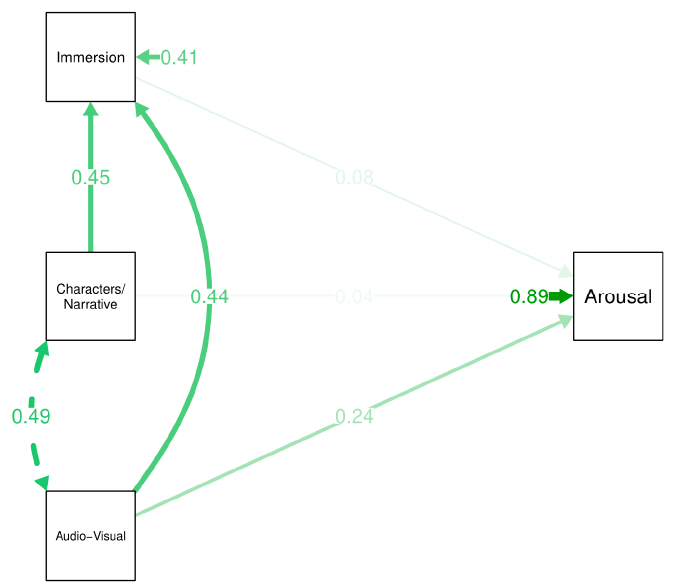
Figure 3. Path diagram for partial mediation model of arousal. Note: aud = audio-visual; chr = char- acters and narrative; imm = immersion; ars = arousal. acters and narrative; imm = immersion; ars =